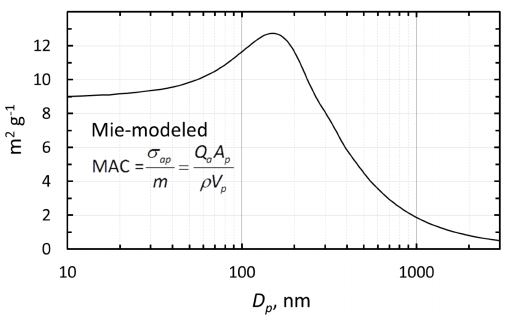
Figure 8. Modeled mass absorption coefficient (MAC) of single BC particles as a function of particle diameter at λ = 526nm.